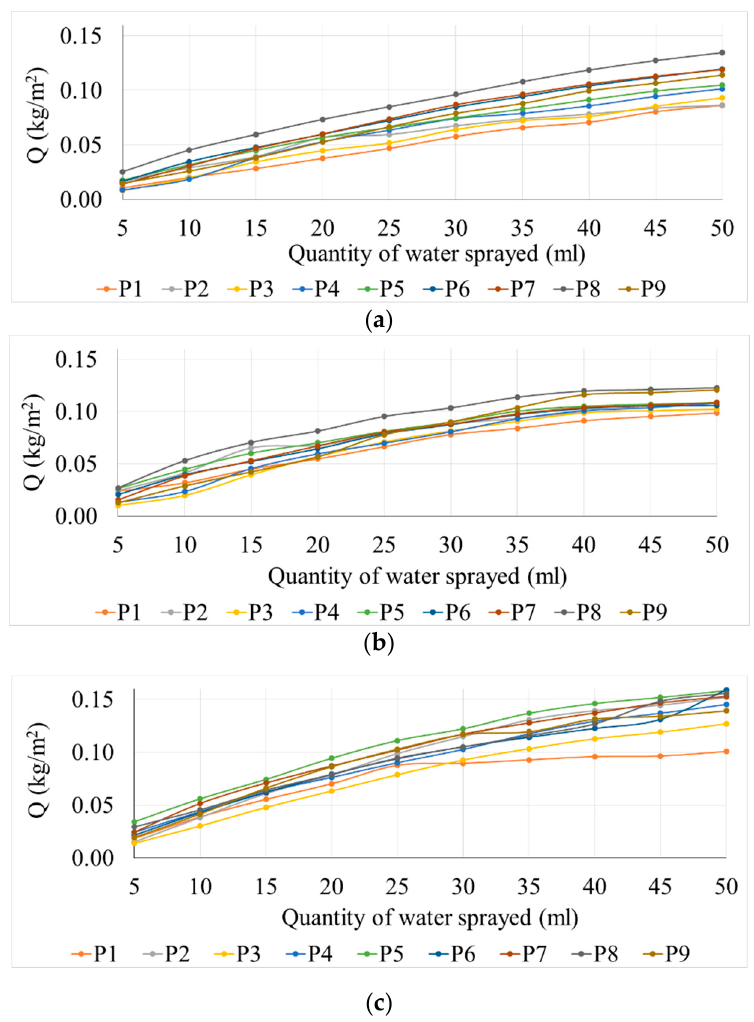
Figure 3. Surface water absorption: ( a ) Non-UV exposed test specimens; ( b ) Specimens exposed 1 h to UV; ( c ) Specimens exposed 1+24 h to UV.